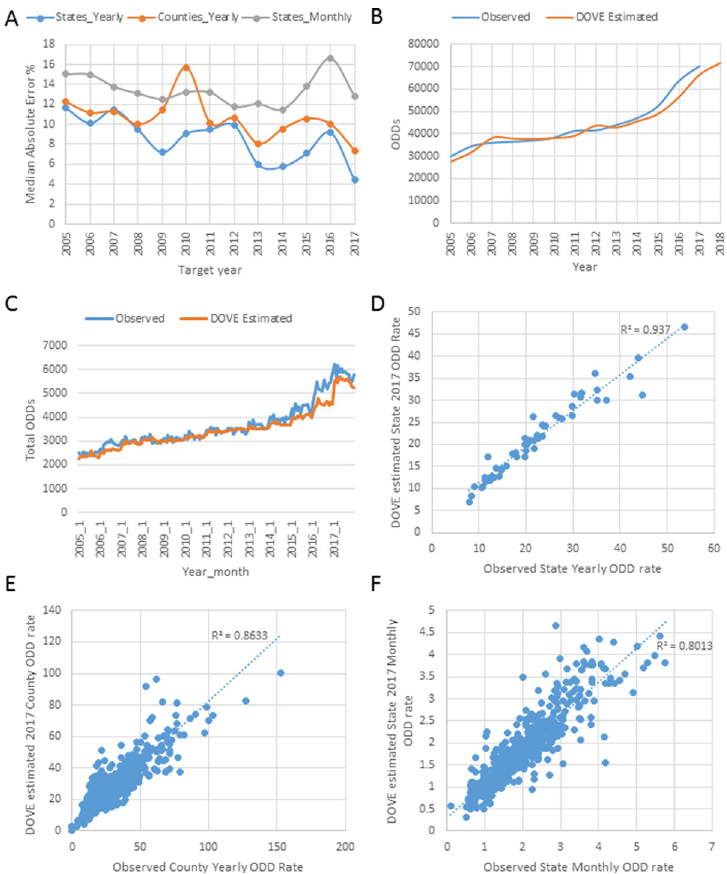
Fig 5. Dynamic Overdose Vulnerability Estimator (DOVE) performance. (A) Median Absolute Error % of the Final Model for Each Target Year; (B) Total number of observed and predicted yearly ODDs; (C) Total number of observed and predicted Monthly ODDs; (D) Predicted versus Observed State 2017 Overdose Death (ODD) Rates; (E) Predicted versus Observed County 2017 ODD Rates; (F) Predicted versus Observed State Monthly ODD Rate in 2017.